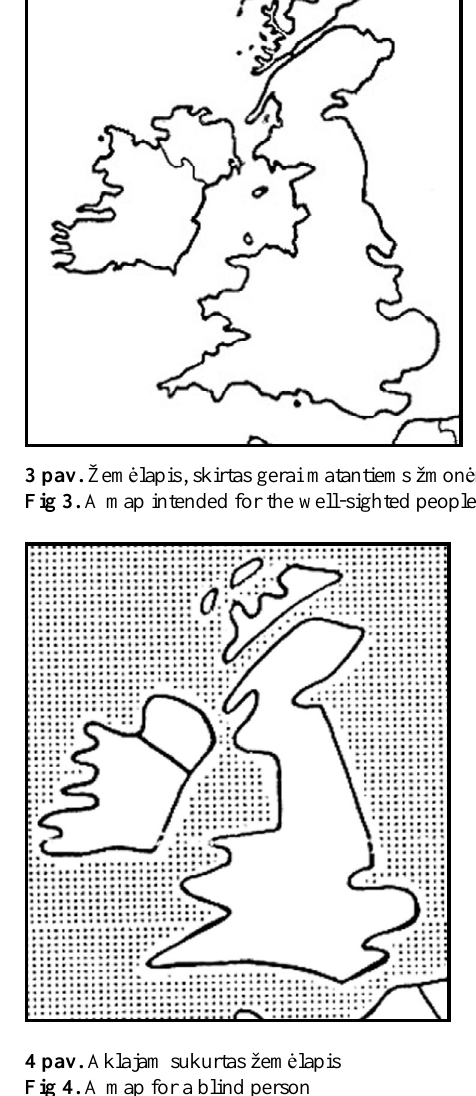
Fig 4. A map for a blind person